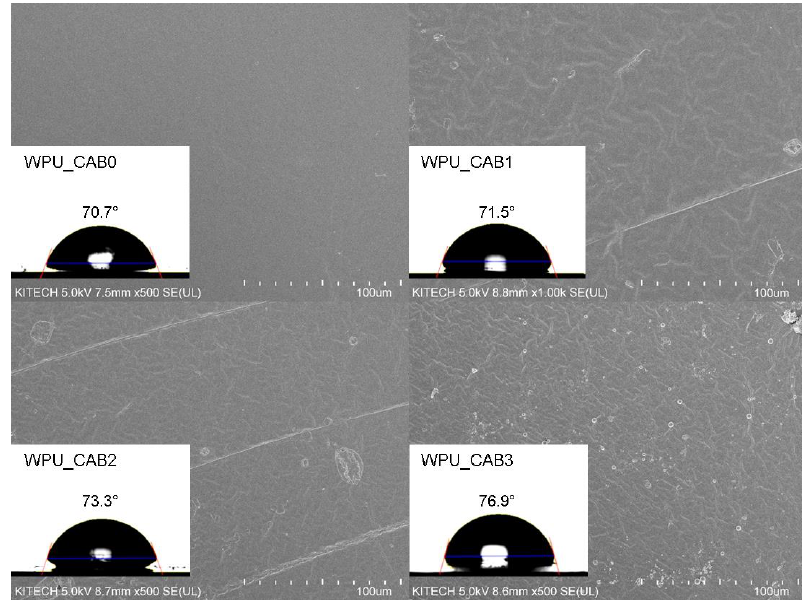
Figure 7. SEM images and water contact angles of WPU films with different CAB contents.